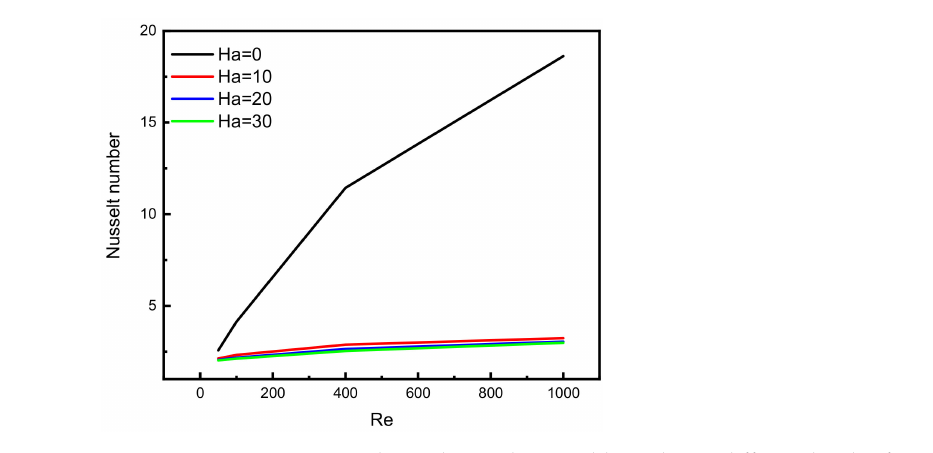
Figure 7. Variation in Nusselt number with Reynold number at different levels of Hartmann number.